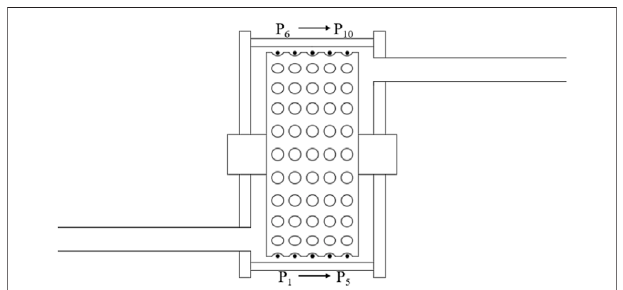
FIGURE13| Pressure fl uctuationspectrumofP 1 -P 5 withdifferentholediameters: (A) D 1 =11mm, (B) D 2 =13mm, (C) D 3 =15mm, (D) D 4 =17mm,and (E) D 5 = 19 mm.